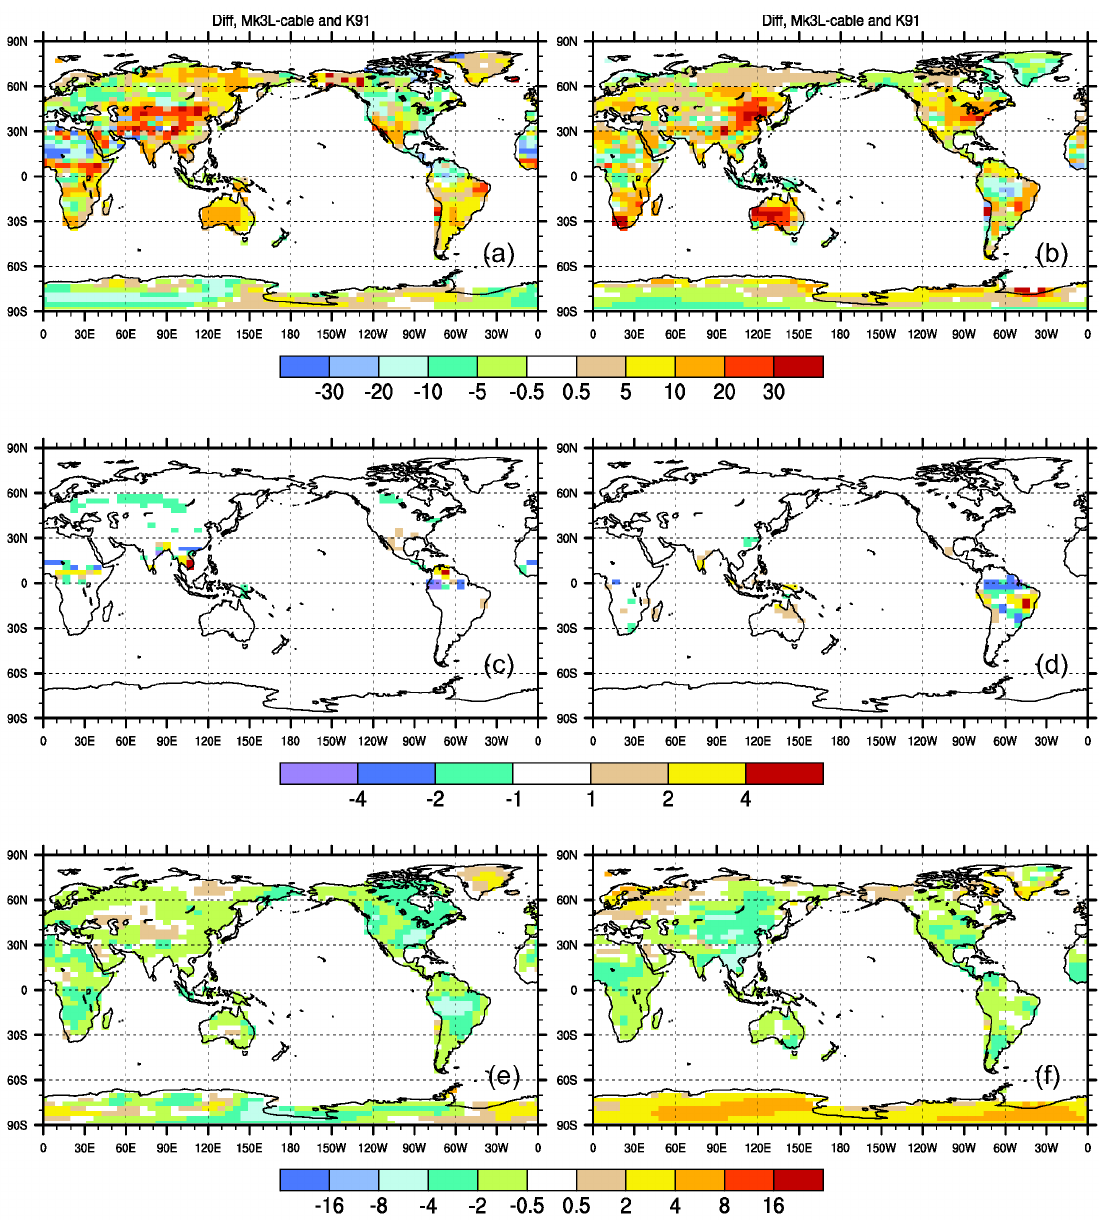
Fig. 6. Difference between Mk3L-CABLE and Mk3L-K91 for (a) net surface radiation for JJA (Wm − 2 ); (b) net surface radiation for DJF (Wm − 2 ); (c) precipitation for JJA (mmday − 1 ); (d) precipitation for DJF (mmday − 1 ); (e) 2m air temperature for JJA (K) and (f) 2m air temperature for DJF (K). Only values over continental surfaces are